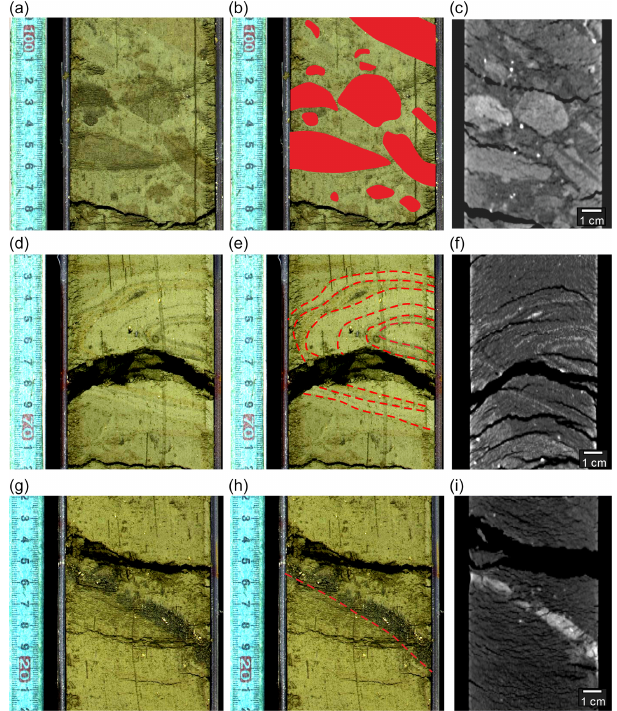
Figure 6. Three examples of deformation structures in the core samples: scattered mud clasts in C9033A-8H-6 (a, b, c) , folded block in C9033A-8H-10 (d, e, f) and overturned bed with a sharp top and inverse grading in C9033A-9H-4 (g, h, i)